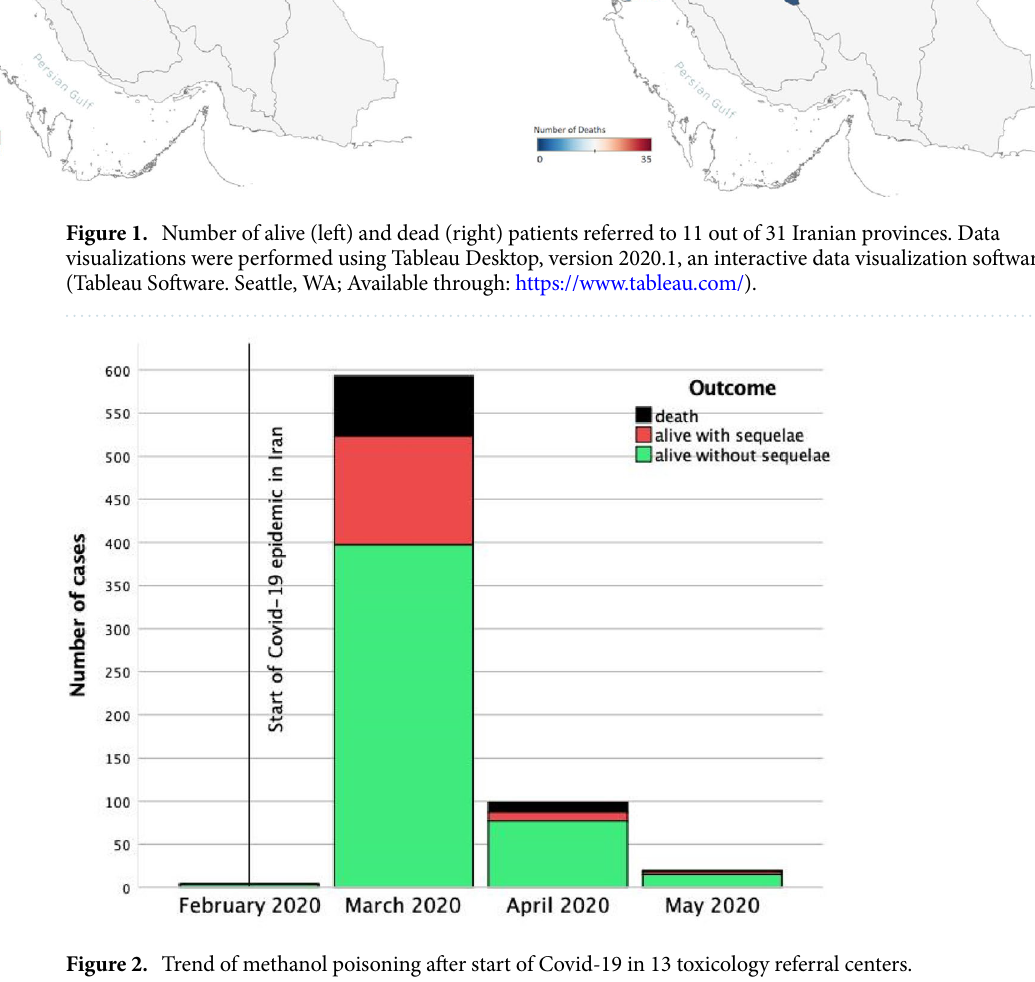
Figure 2. Trend of methanol poisoning after start of Covid-19 in 13 toxicology referral